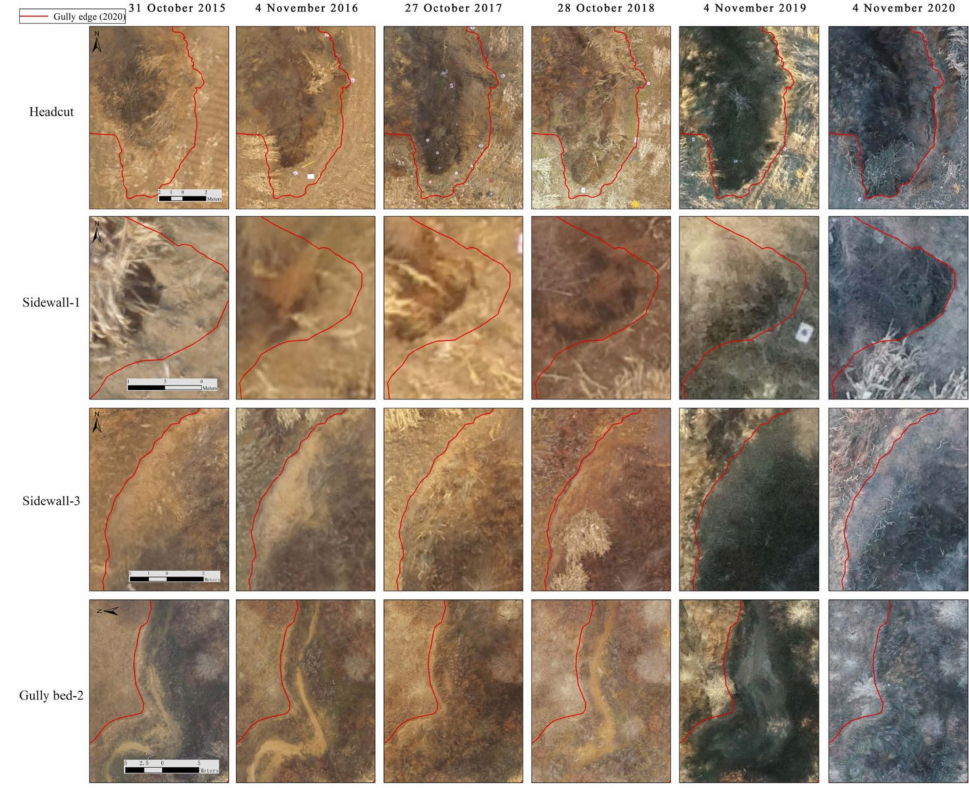
Figure 8. Morphological changes of the gully between 2015 and 2020 based on UAV